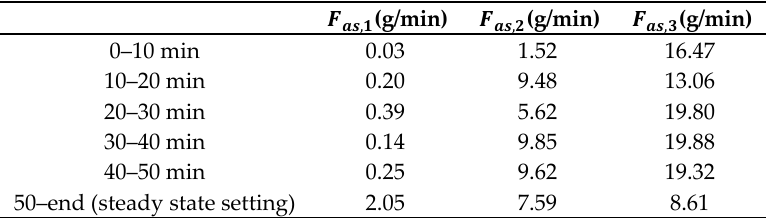
Table 4. Optimal antisolvent flow rate profiles obtained by the dynamic optimization